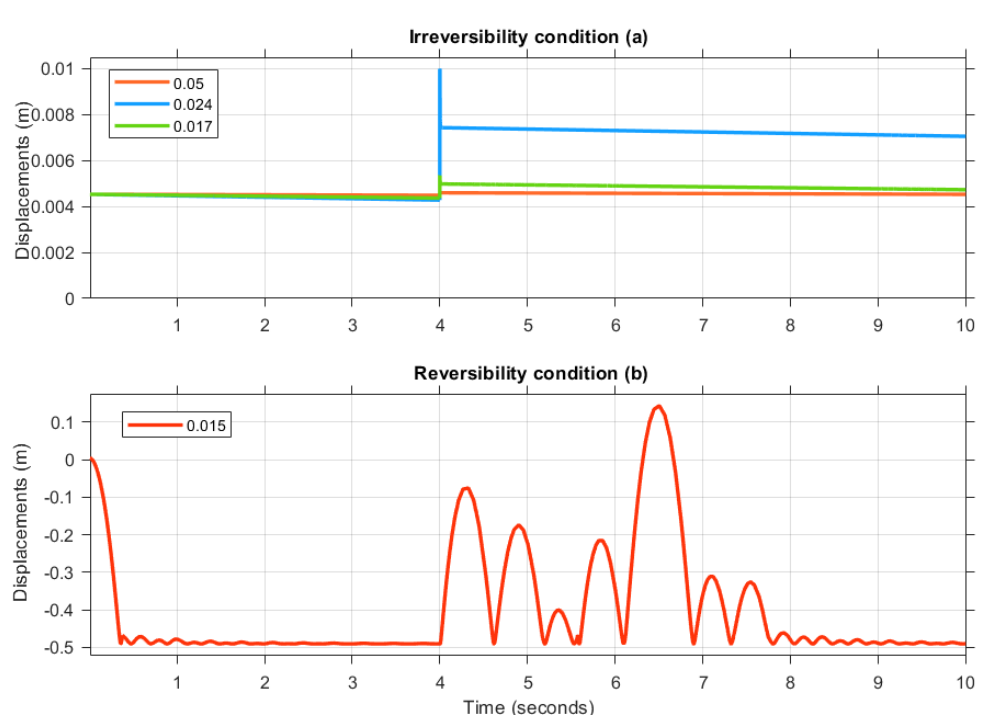
Figure 9. Correlation of the reaction forces determined with increasing dynamic friction coefficients: ( a ) Irreversibility condition; ( b ) Reversibility